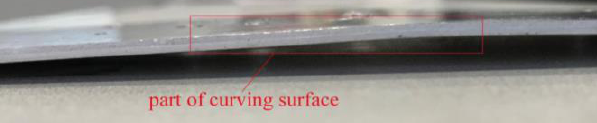
Fig. 13. Surface with curving